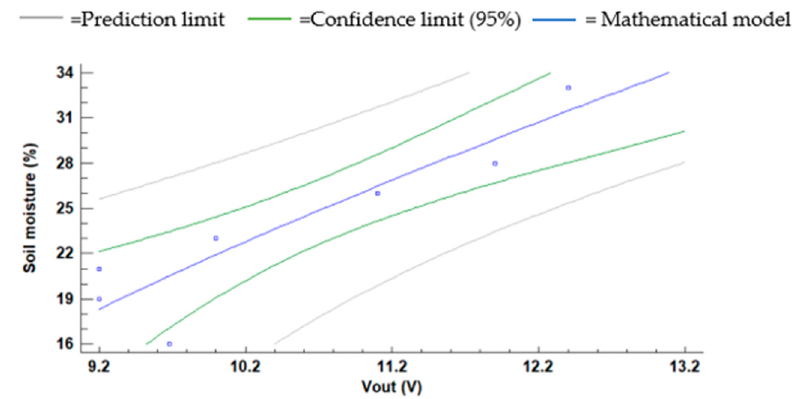
Figure 22. Vout of P8 using S5 and its mathematical model.